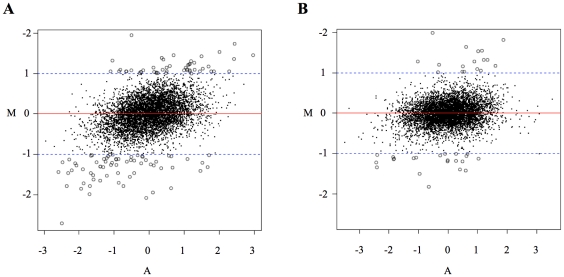
PBM analysis of AP2α extracted from healthy or tumor tissue samples.(A) Result of a comparison between 4 normal samples and 4 cancer samples, in the form of an MA-plot. The X-axis (A values) shows the average of the log ratios (protein/DNA) of binding from normal and cancer extracts to each target DNA sequence, and it thus displays the average AP2 binding value to each gene. The Y-axis (M values) represents the averaged difference of log ratios (protein/DNA) between the normal and the cancer samples, and thus represent differential binding when comparing healthy and diseased tissues. Potential differential binding was defined as an absolute value of M>1, as shown with dashed lines, corresponding to a 2-fold difference between cancer and normal tissues. 149 genes were selected using this cut-off. Circles indicate statistically significant differential binding. (B) Same data for a comparison between two sets of 4 randomly selected cancer samples; 52 genes were selected using the same criteria as for panel (A).